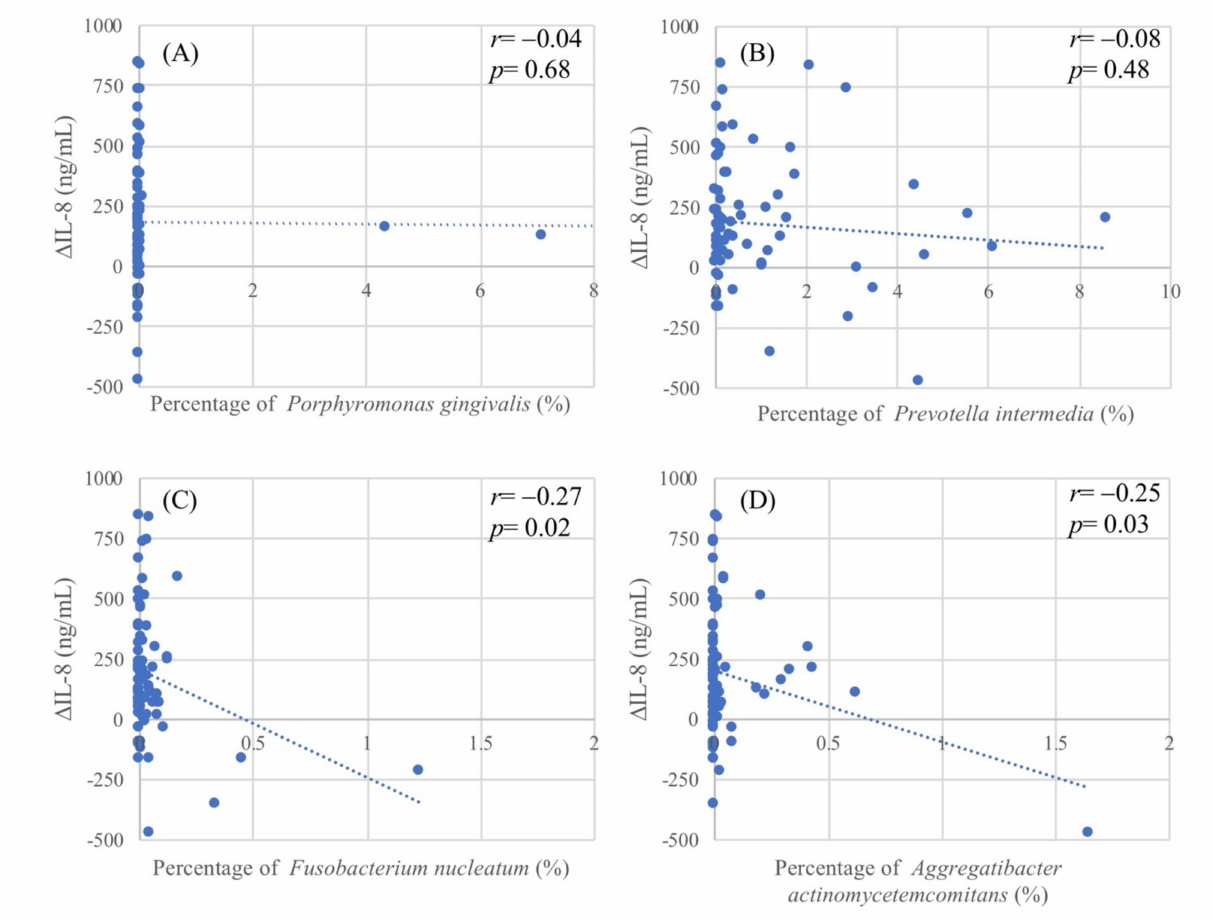
Figure 1. Scatter plots of differences between pre- and post-treatment levels of salivary interleukin-8 (IL-8) in patients with periodontitis versus respective percentages of representative bacterial species in the oral microbiota: ( A ) Porphyromonas gingivalis ; ( B ) Prevotella intermedia ; ( C ) Fusobacterium nucleatum ; and ( D ) Aggregatibacter actinomycetemcomitans . ∆ IL-8 (ng/mL) = baseline IL-8–post-treatment